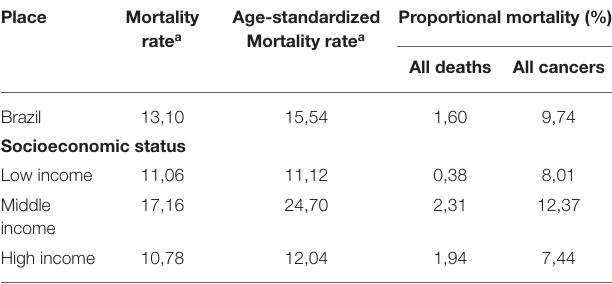
TABLE 1 | Mean mortality rates and age-adjusted mortality rates due to stomach cancer, proportional mortality for all deaths and proportional mortality for all cancers,